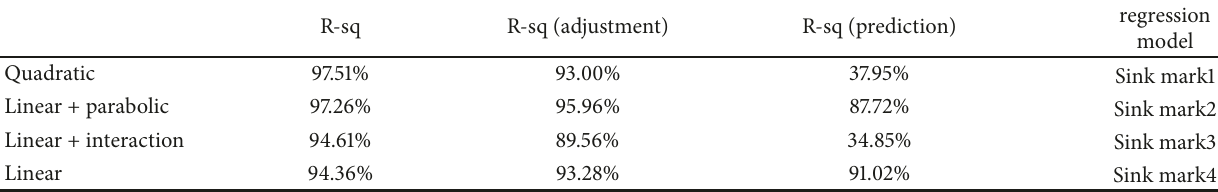
Table 8: Fitting results of the sink marks using the four regression